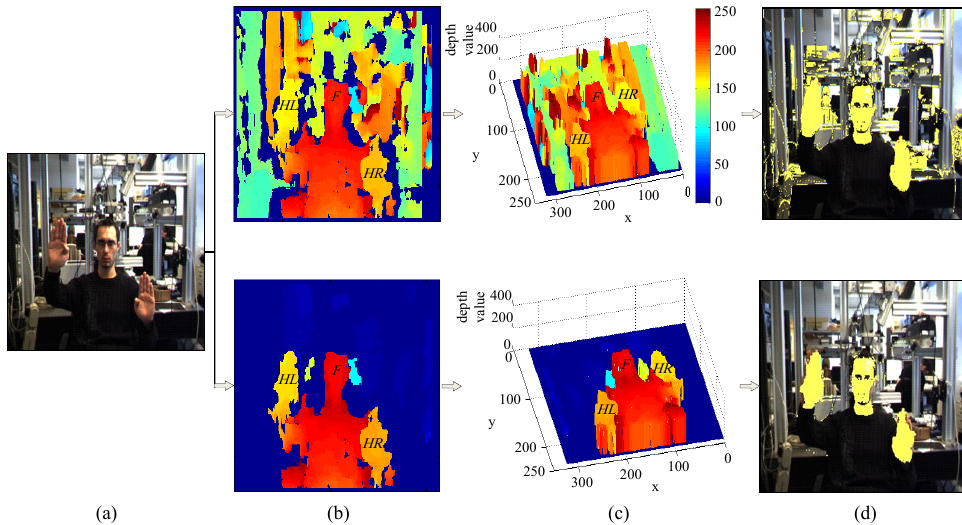
Figure 2. ( a ) Source image; ( b ) depth images with normalization; ( c ) 3D depth images with with normalization; ( d ) skin detection according to a depth value of up to 10 m for the top image. The bottom image depicts skin pixel detection with no noise (a depth value between 30 cm and 200 cm). The identification of skin pixels is indicated by the yellow color